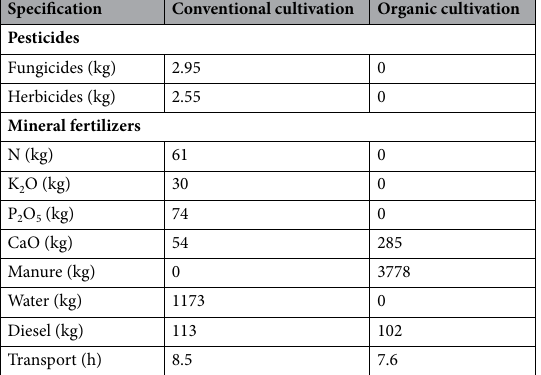
Table 1. Comparison of the consumption of selected means of production in conventional and organic carrot production per cropping area